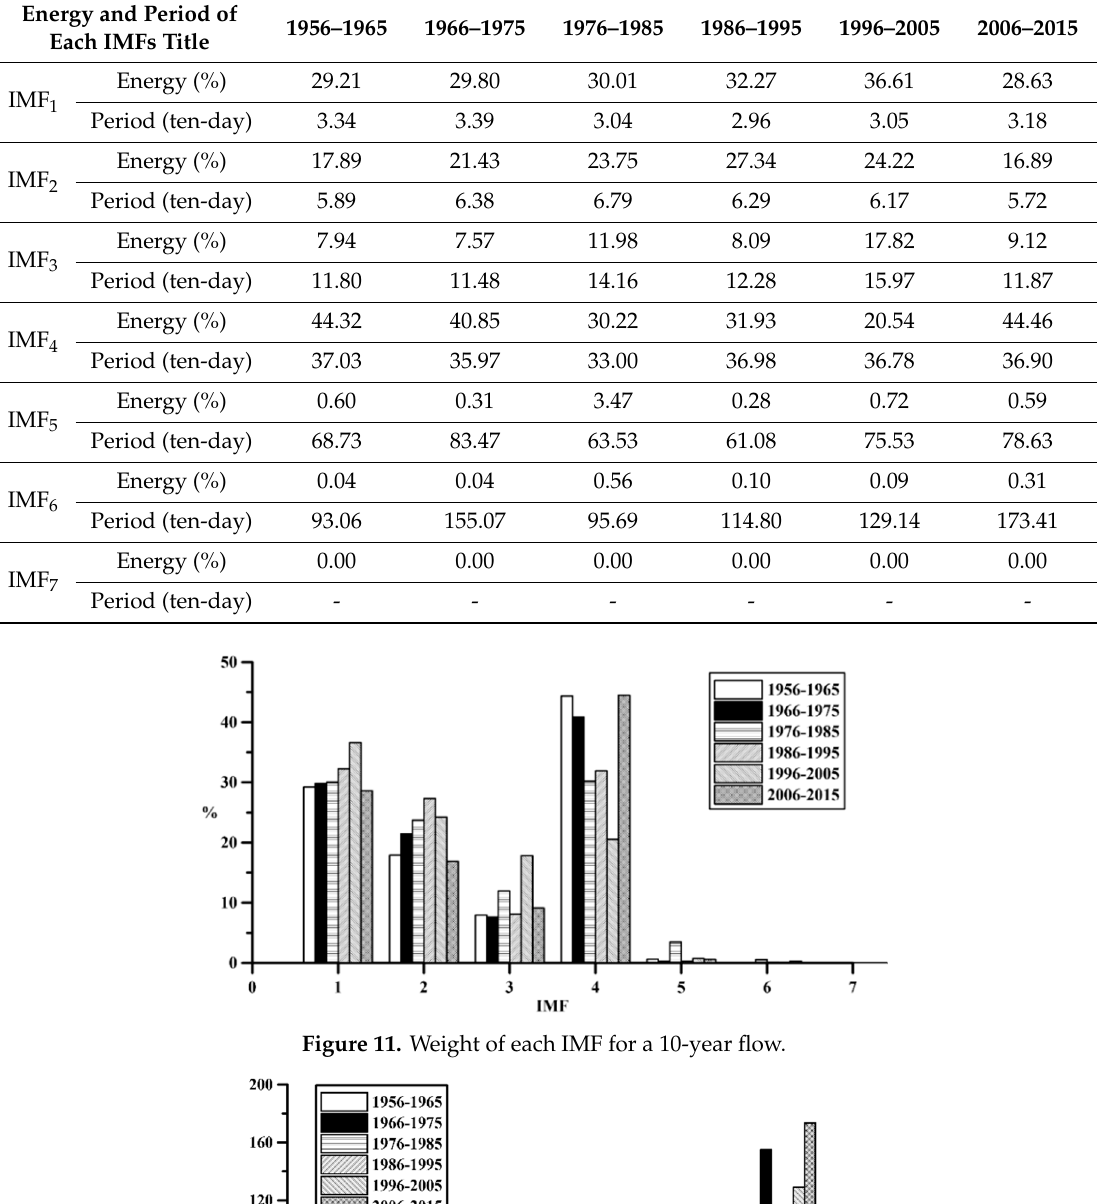
Figure 10. Average period of each IMF for a 60-year flow.